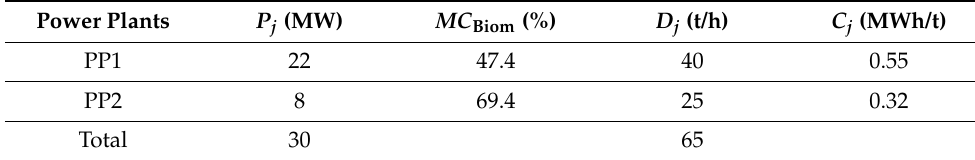
Table 2. Data for power plants in Example 1.